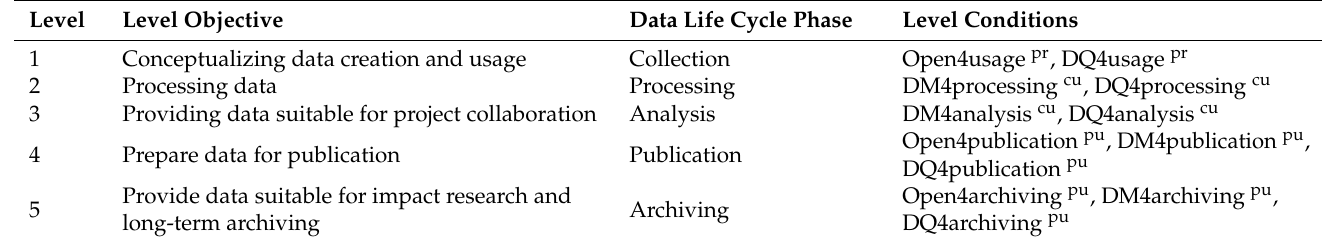
Table 2. Levels and their objectives for the QA workflow along the data life cycle. Level conditions are defined by data provider (pr), data curator (cu), or data publisher